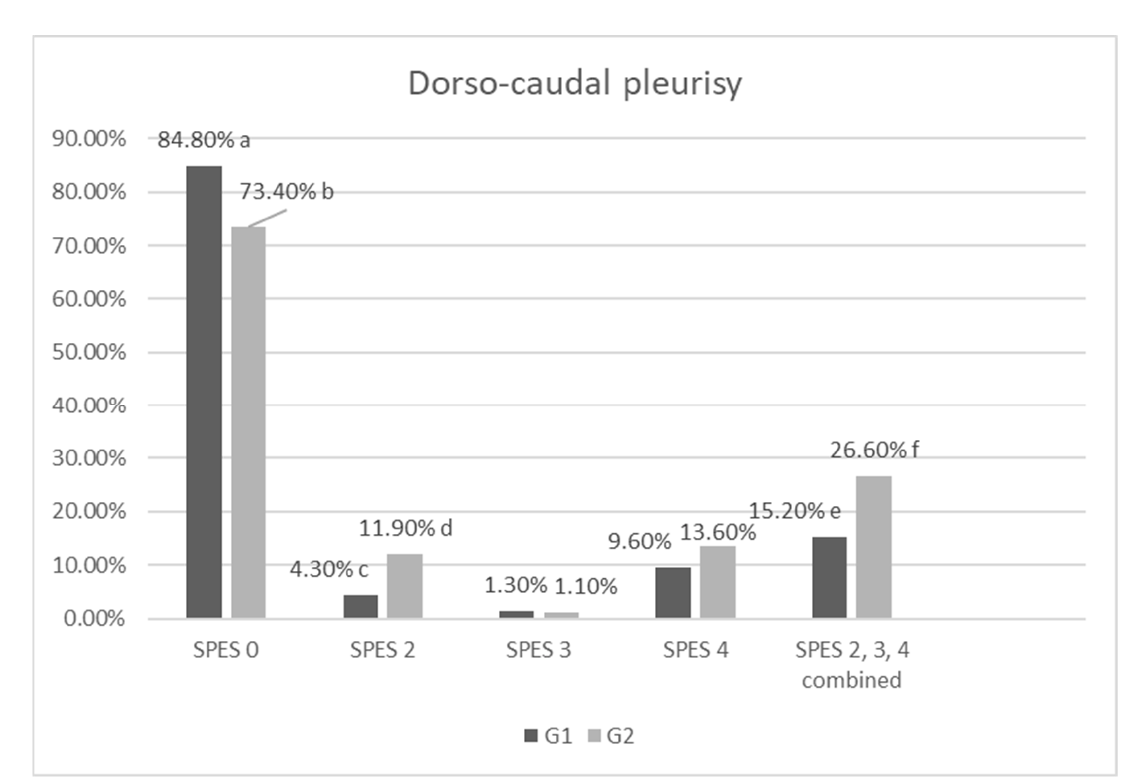
Figure 1. Distribution of pleuropneumonia-like pathological lesions between groups (a:b p < 0.001; c:d p = 0.048; e:f p = 0.015).